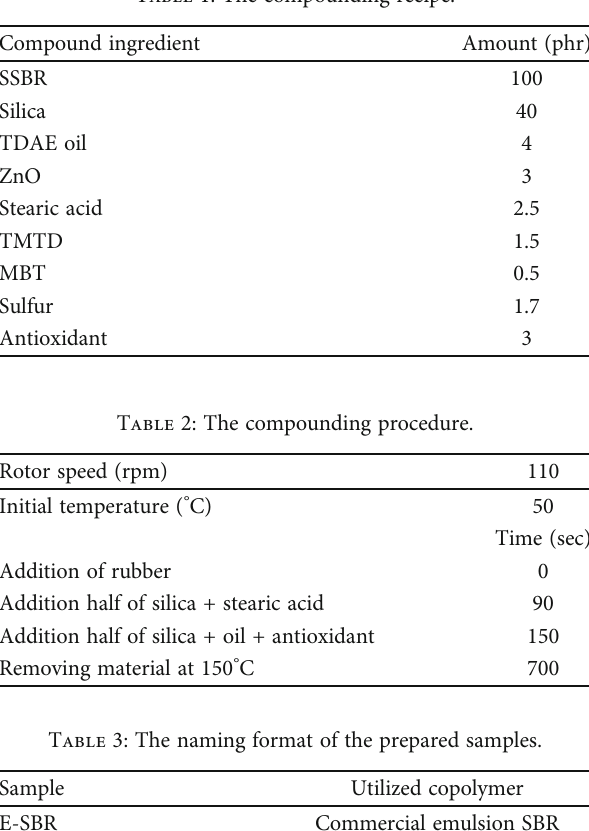
Table 1: The compounding recipe.